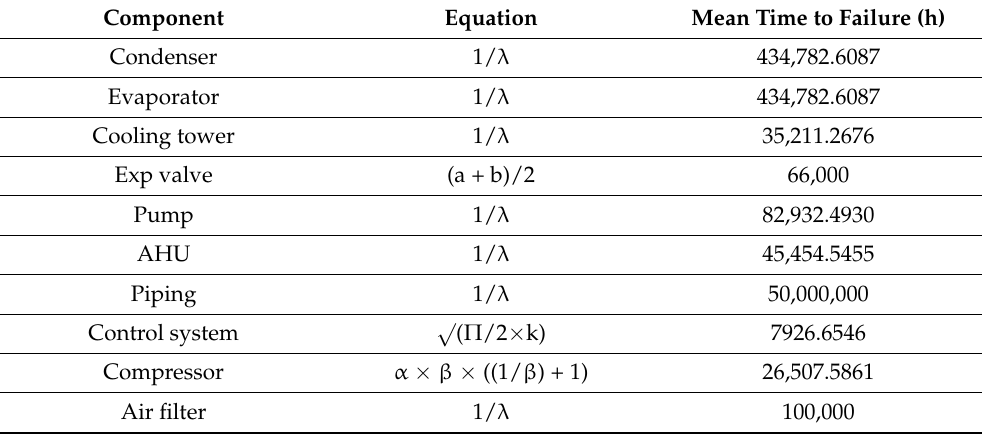
Table 3. List of MTTFs for each component in the system.